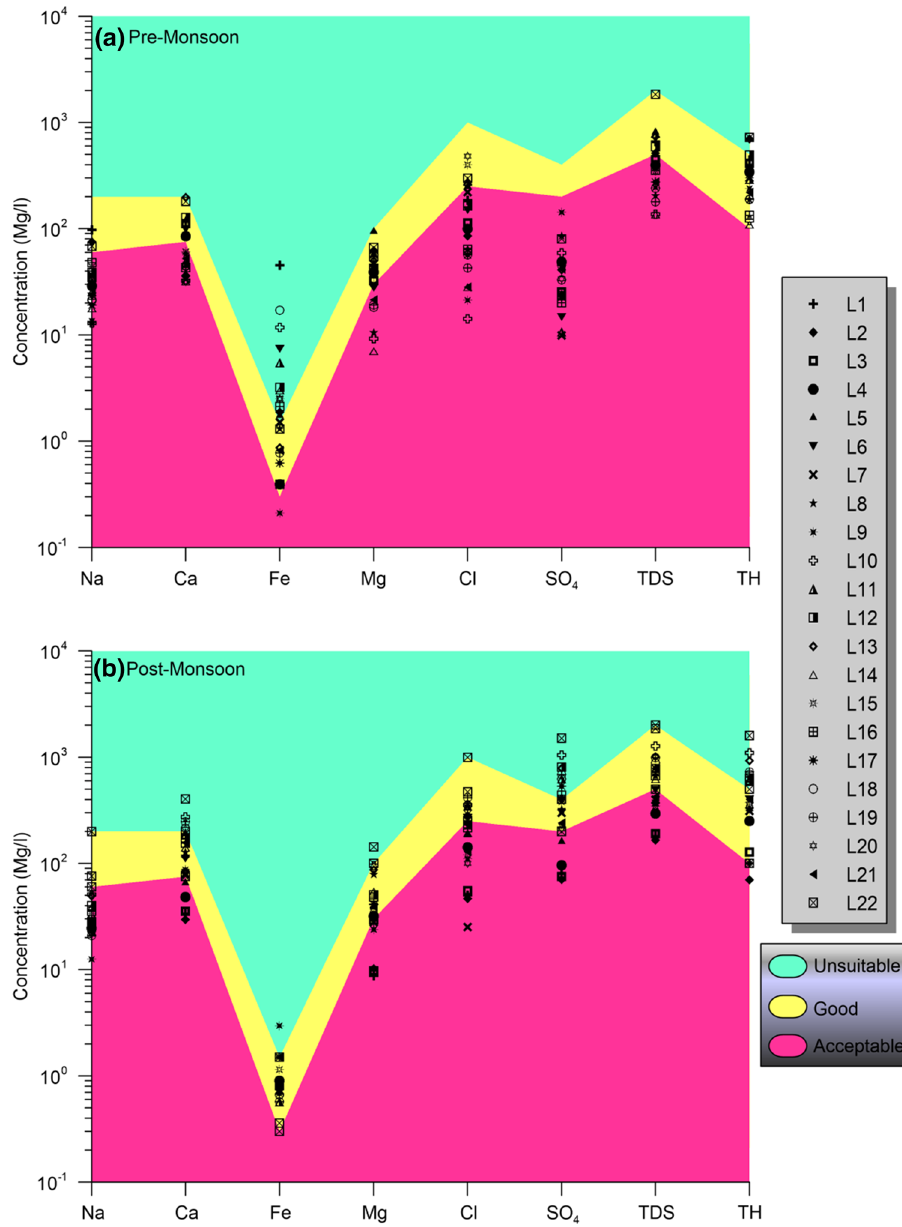
Fig. 14 Schoeller diagram; a PrM; b